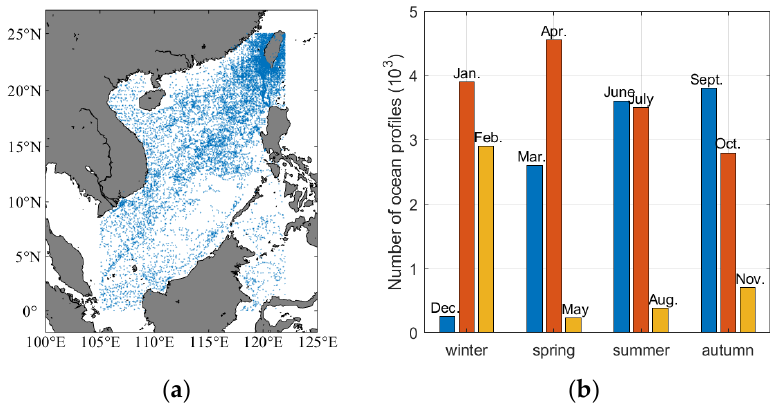
Figure 1. Distribution of sites ( a ) and the number of ocean profiles ( b ).